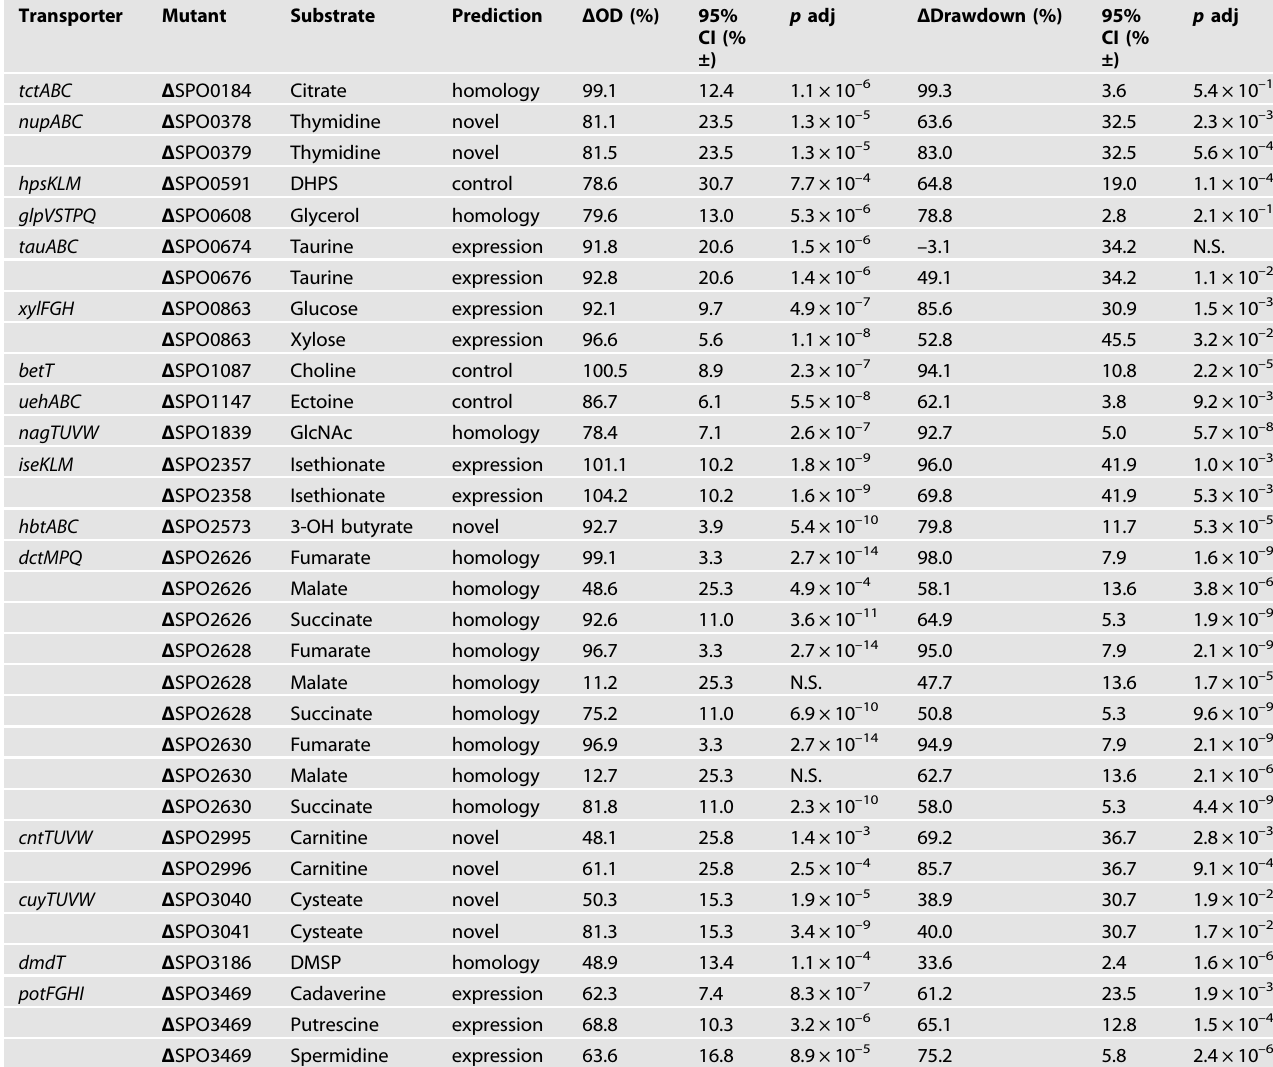
Table 1. Transporter identi fi cation based on growth and metabolite drawdown screens.